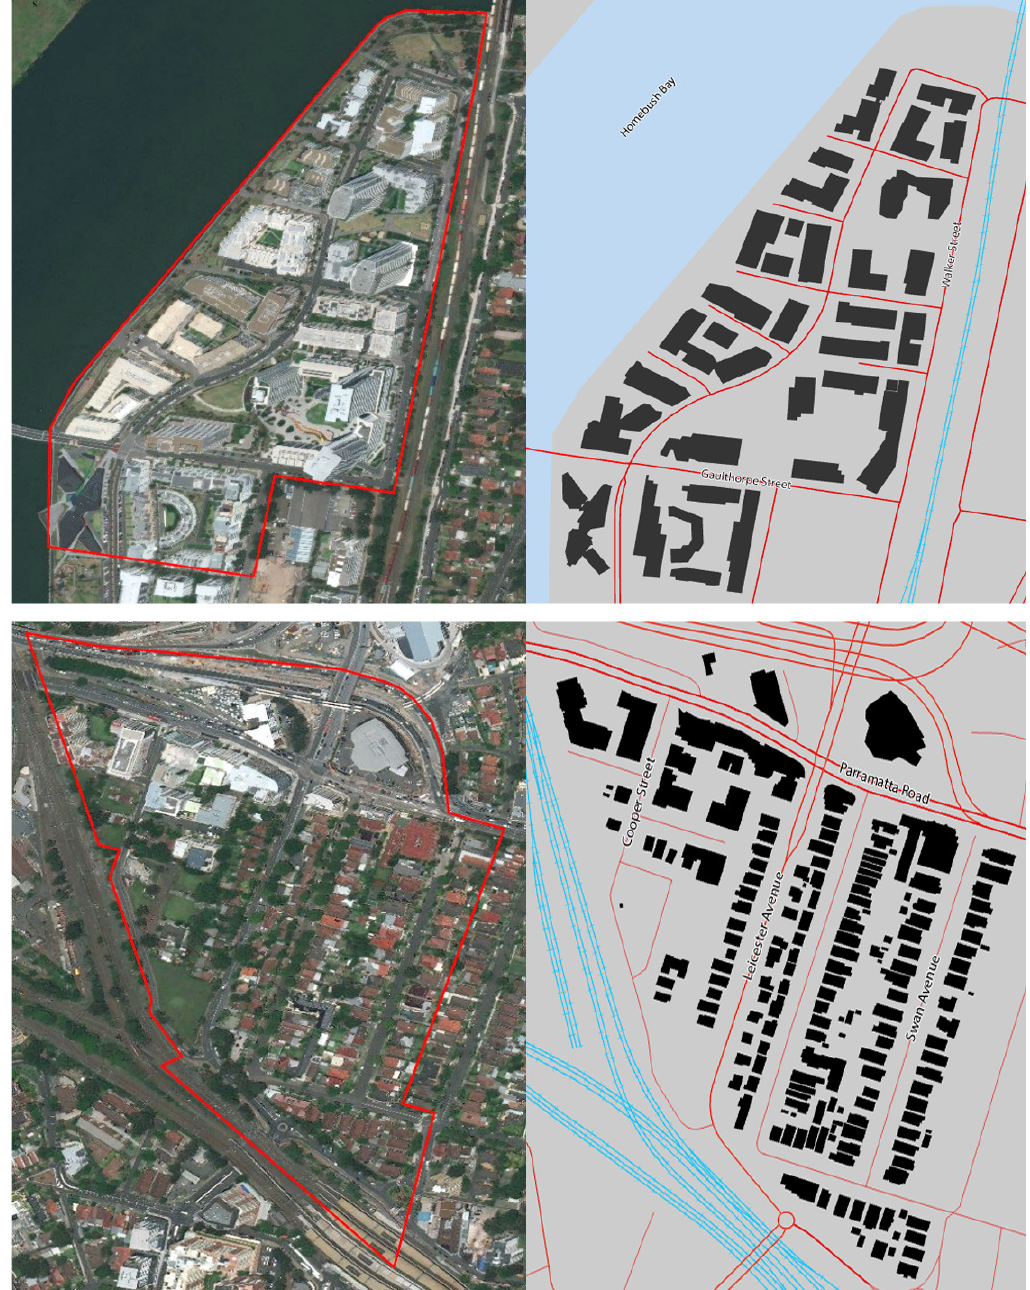
Figure 2. Rhodes West (top) and Upper Strathfield (bottom). Source: Authors’ work using Google Earth and